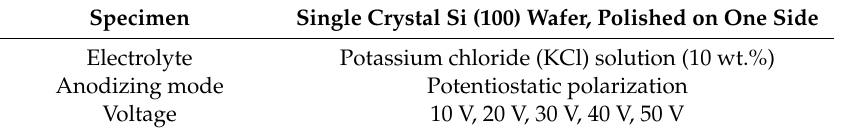
Figure 1. Schematic diagram of the experiment setup for electrochemical oxidation process. Table 1. Experimental conditions for anodizing of Si wafer.